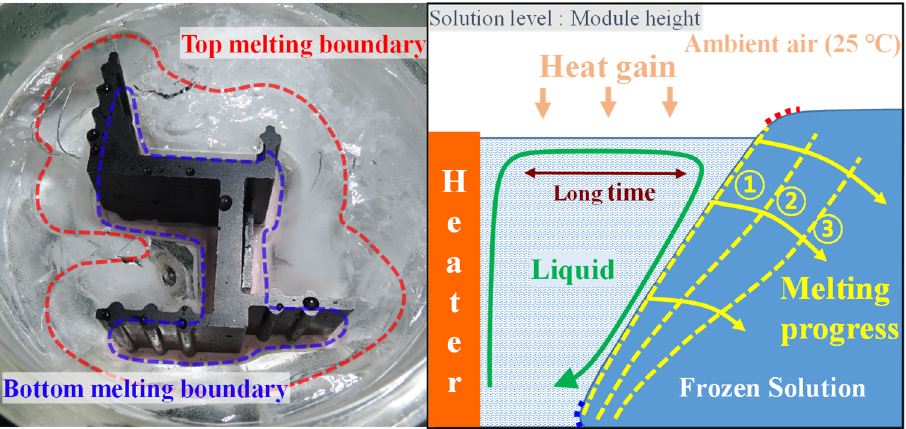
Figure 7. Top view of frozen solution, and schematic of phenomenon with time (Module_1); condition: Case_1 (level: Module height)/420 s.